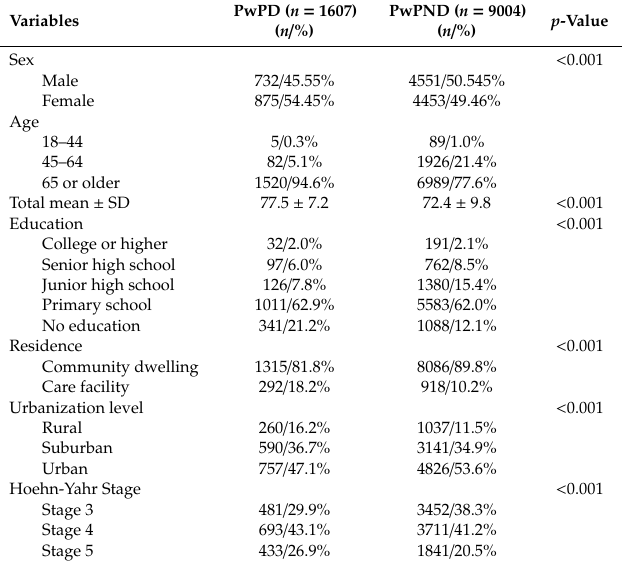
Table 1. Demographic data of the enrolled population ( n =